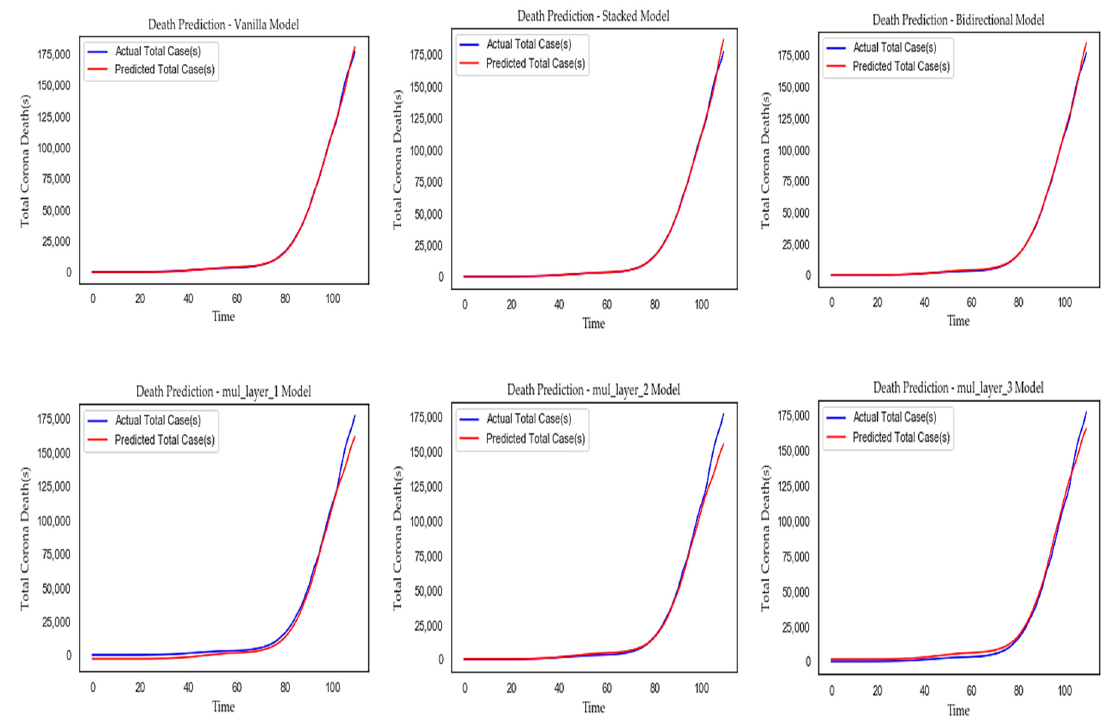
Figure 11. Comparing the calibration of the LSTM models to forecast total deaths of the “World”.